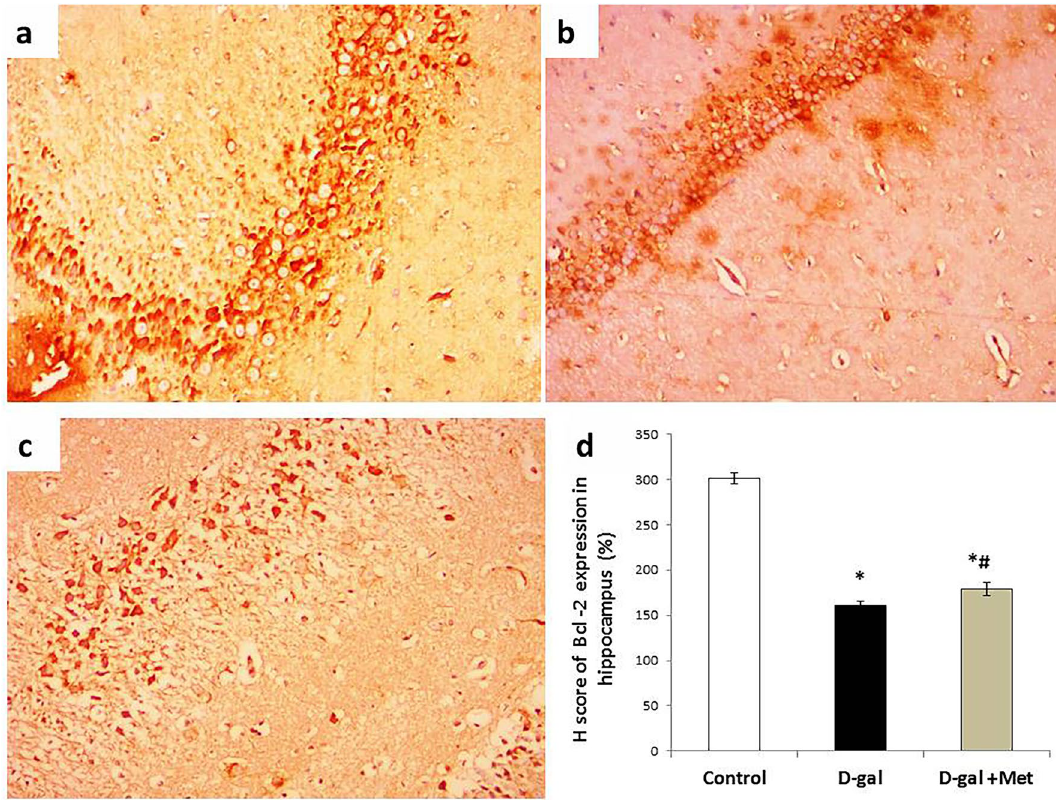
Figure 10. Bcl-2 immunostaining in hippocampal tissues of the studied groups. ( a ) Section of the hippocampal tissue in the control group showed intense cytoplasmic expression of Bcl-2 in neural cells. ( b ) Section of the hippocampal tissue in the D-gal group showed mild focal cytoplasmic expression of Bcl-2 in neural cells. ( c ) Section of the hippocampal tissue in the D-gal + Met group showed moderate cytoplasmic expression of Bcl-2 in neural cells (Bcl-2 × 200 for A, B and C). ( d ) Represents the percentage of Bcl-2 expression in the above- mentioned groups (*significant when compared to control group, # significant when compared to D-gal group). Data are shown as means + SD (n = 10). ANOVA was used to make group comparisons; significance = P <